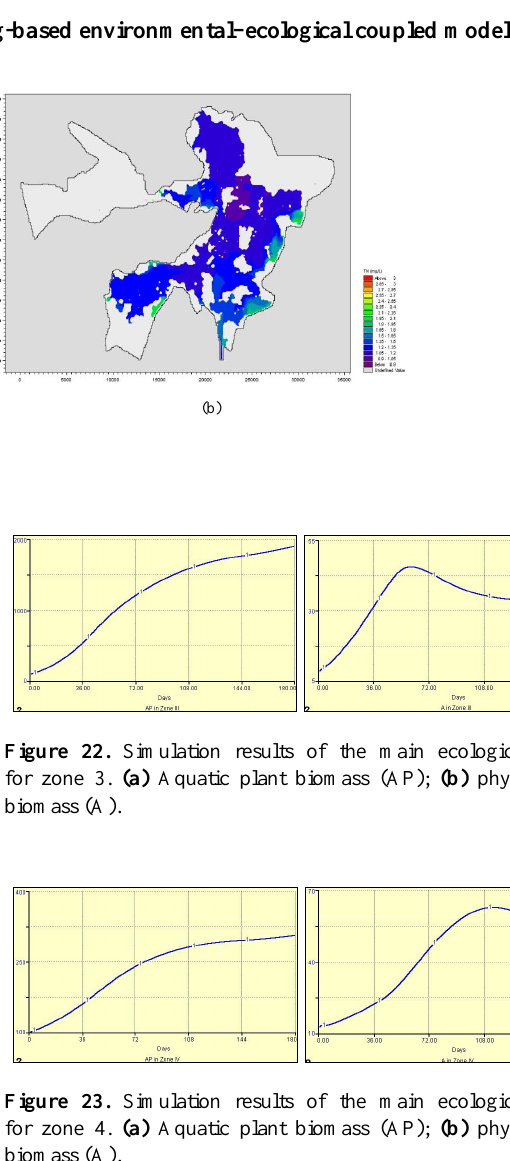
Fig. 21. Simulation results of the main ecological indexes at zone II Figure 21. Simulation results for the main ecological indices for zone 2. (a) Aquatic plant biomass (AP); (b) phytoplankton biomass (A). Fig. 22. Simulation results of the main ecological indexes at zone III